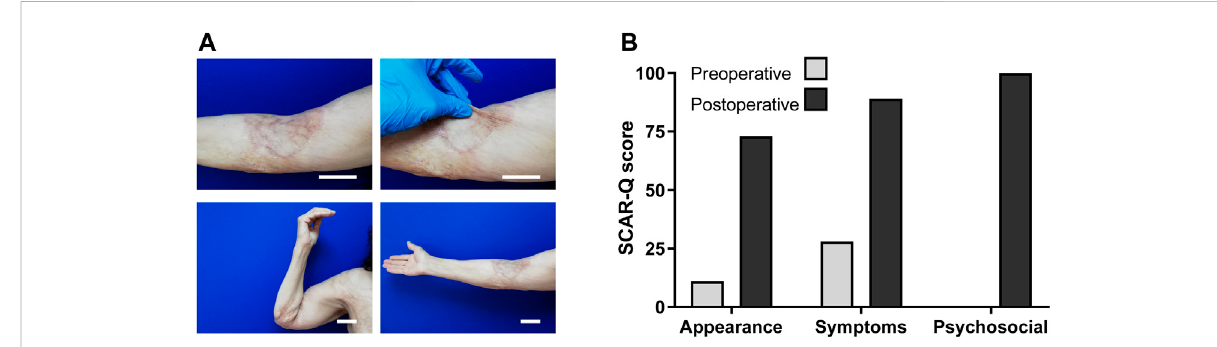
FIGURE 4 Qualitative outcome and self-evaluation. (A) Long-term photograph of the complete integration of photosynthetic scaffold and autologous split-thickness skin graft after 17 months. Detail of the skin graft outcome, and qualitative pinch-test performed in the treated area. Photographs show the entire arm achieving full-range fl exion and extension, underscoring the gain in fl exibility and elasticity in the regenerated area. Scale bars represent 5 cm. (B) A personal survey instrument to measure the patient-perceived outcome of the surgical procedure was applied at the month 17. The results reported in the three categories evaluated (appearance, symptoms and psychosocial) show an increased score in the self- perception of the injured area after the full treatment. An increased score in each category implies a better perception. No bar is observed in preoperative psychosocial survey, as SCAR-Q score was